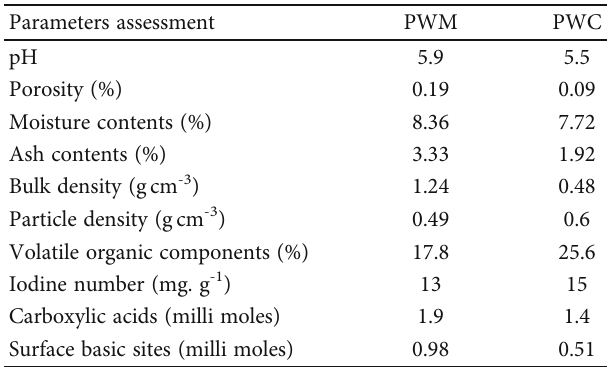
Table 2: Physicochemical characterizations of raw adsorbents. Parameters